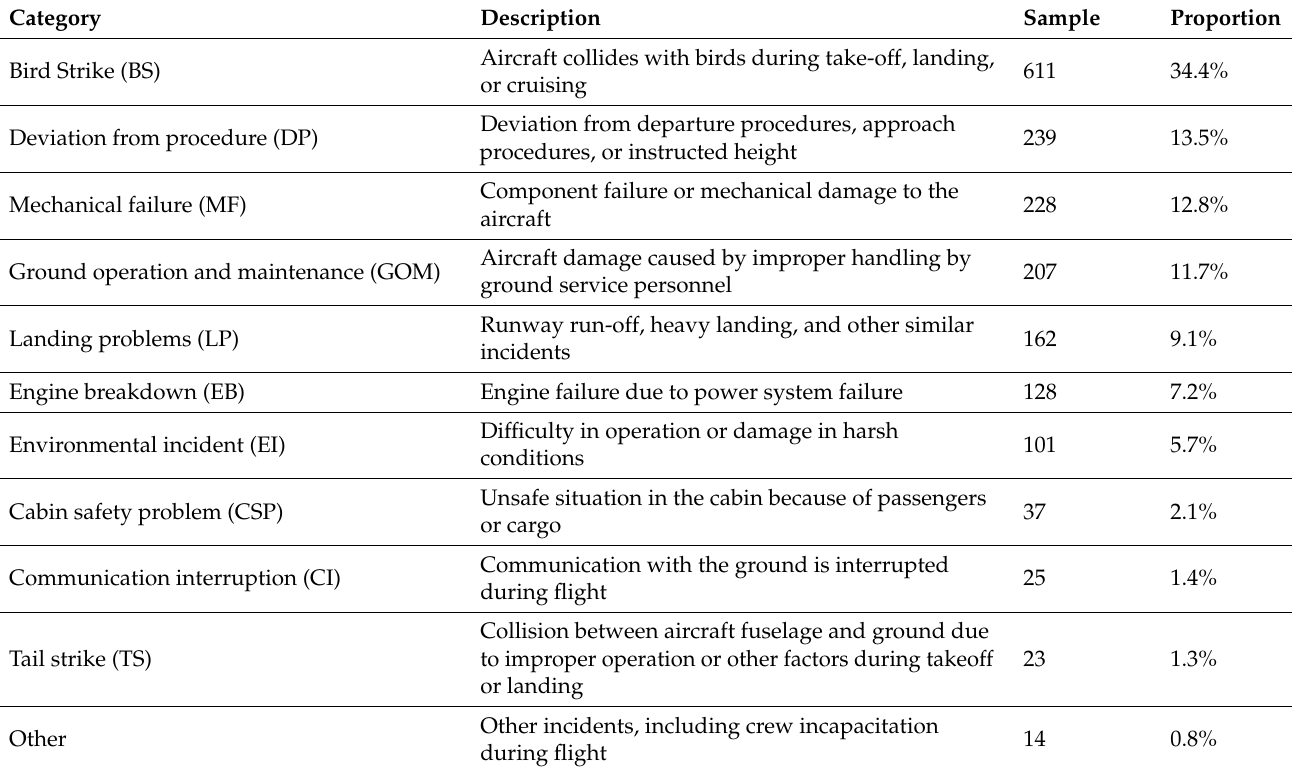
Table 2. Incident categories, description and their